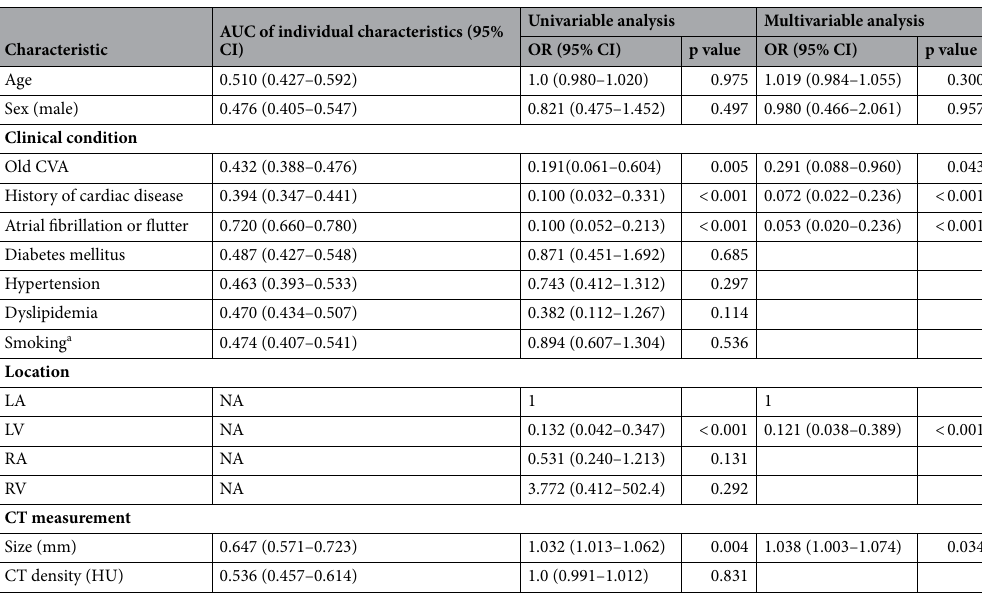
Table 2. Univariable and multivariable analysis of training dataset for the clinical model (clinical and CT variables) predicting the cardiac tumor. Values are presented as mean value (± standard deviation) or patient number (%). AUC Area under the curve, NA not applicable. a Current or former smoker.